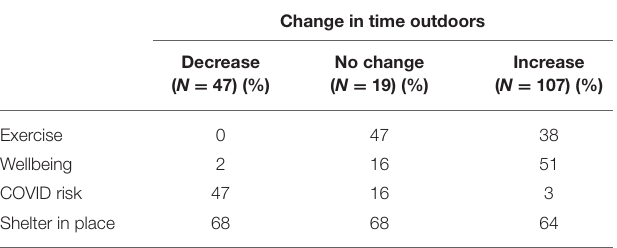
TABLE 3 | Motivations described by change in time outdoors. Change in time outdoors